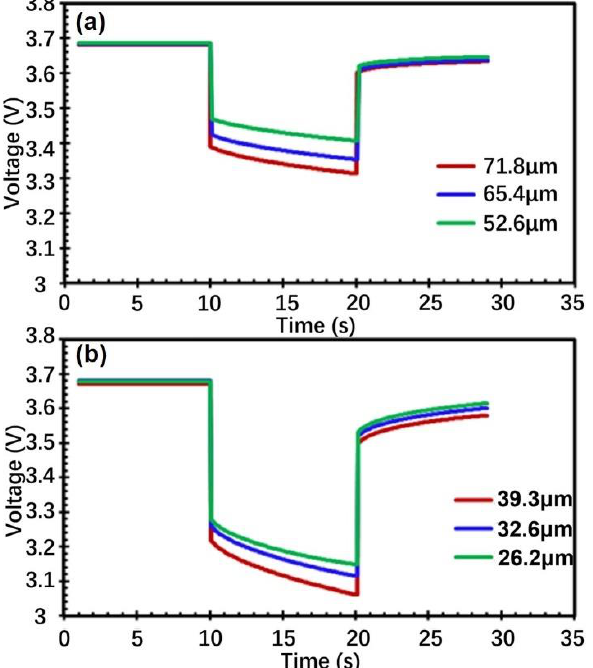
Figure 8. Pulse discharge curves for cells with different electrode thicknesses at 50% SOC: ( a ) 5 C discharge for 10 S; ( b ) 15 C discharge for 10 S.